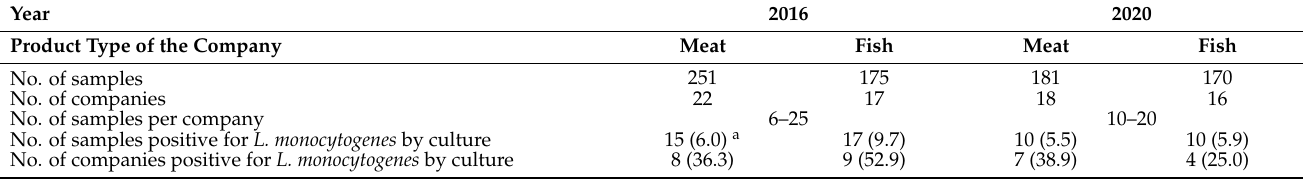
Table 1. Number of samples and participating companies for sampling of food processing environ- ment for Listeria monocytogenes in 2016 and